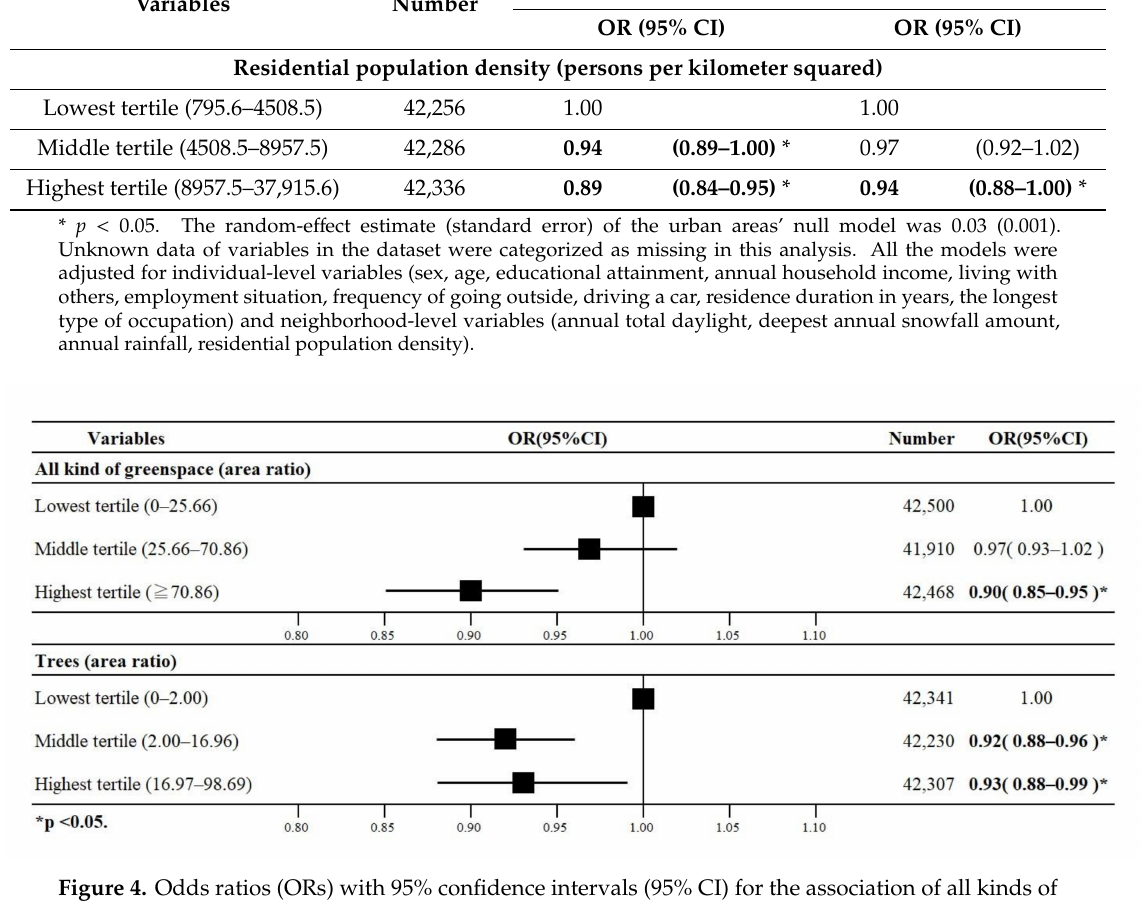
Figure 4. Odds ratios (ORs) with 95% confidence intervals (95% CI) for the association of all kinds of greenspace and trees with depression among older Japanese adults ( n =